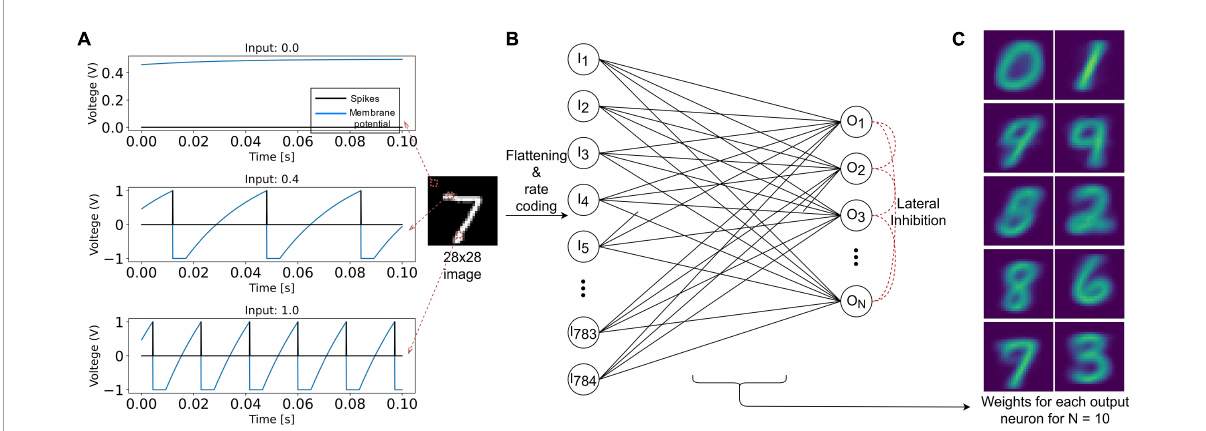
FIGURE3 Representation of the SNN implementation used in this study to benchmark the VDSP learning rule with the MNIST classification task. (A) The response of the LIF neuron used in this study is plotted for input current of magnitude 0 (black pixel), 0.4 (gray pixel), and 1 (white pixel) for a duration of 100 ms. In (B) , 28 × 28 grayscale image is rate encoded with the help of 784 input LIF neurons. Each sample is presented for 350 ms. The input neurons are fully connected to the ALIF output neurons connected in Winner Takes All (WTA) topology for lateral inhibition. (C) The weight matrix for each of the 10 output neurons.